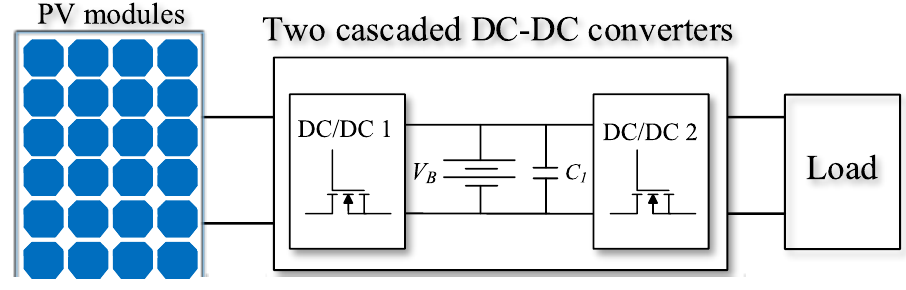
Figure 1. Classical structure of a PV energy harvesting